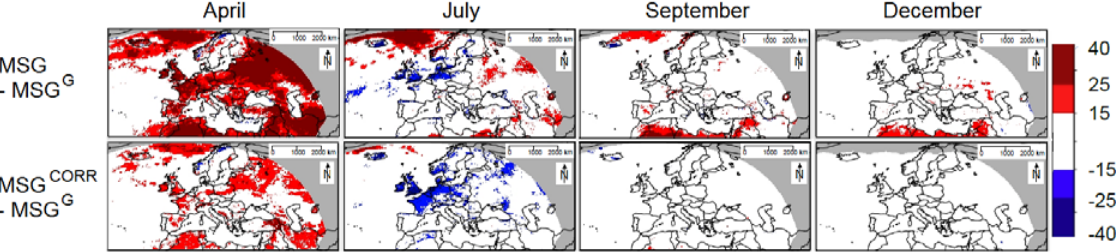
Figure 11. (Top row) Monthly differences (W·m − 2 ) between Meteosat 7 (MFG) and Meteosat 8 (MSG G ) derived SIS, and (bottom row) between the corrected SIS derived from Meteosat 7 and Meteosat 8 derived